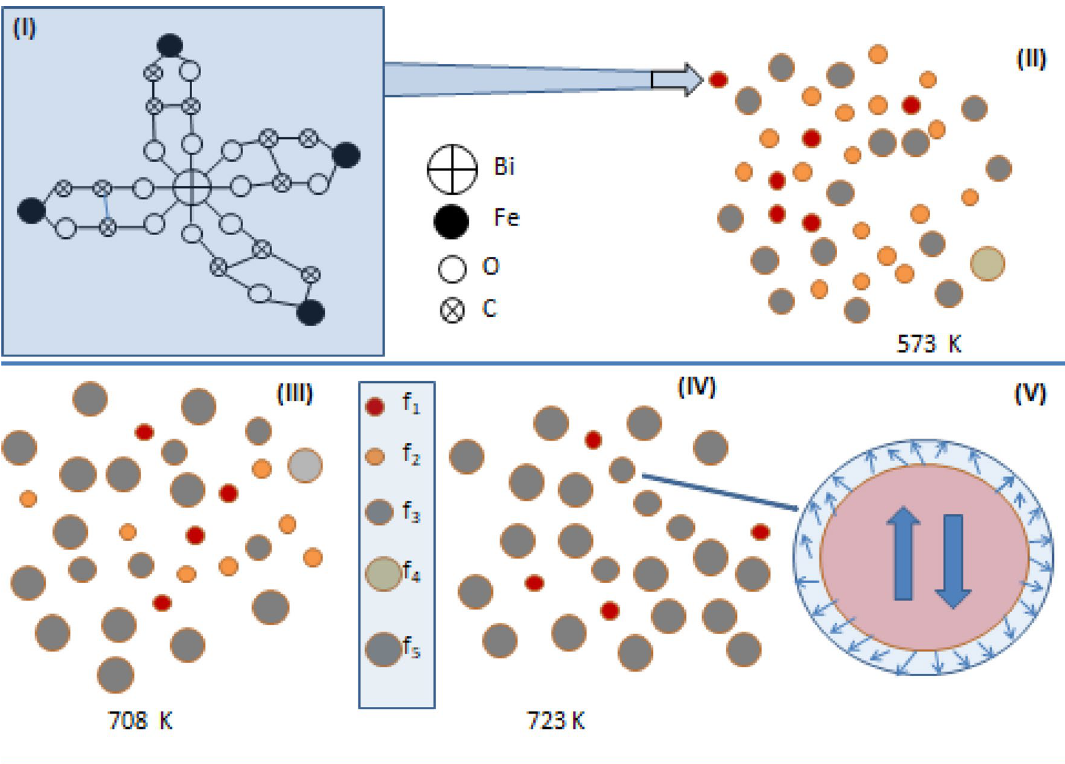
iron oxide particles get dissociated and react leading to dominant formation of BiFeO 3 . (iv) Sample annealed beyond 700 K has fine particles of BiFeO 3 exhibiting AFM core and weakly FM shell as shown in the schematic corresponding to